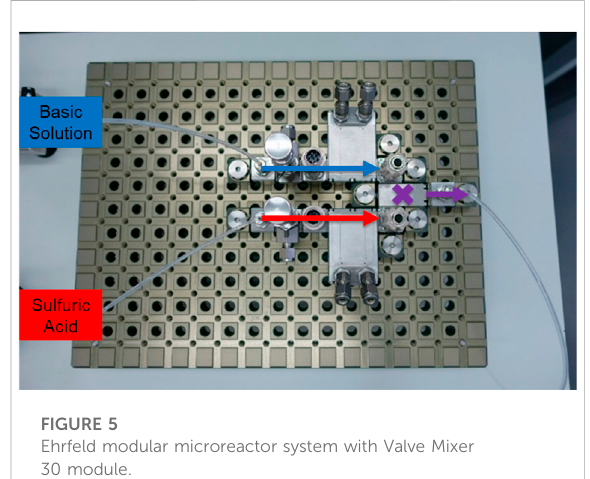
FIGURE 5 Ehrfeld modular microreactor system with Valve Mixer 30